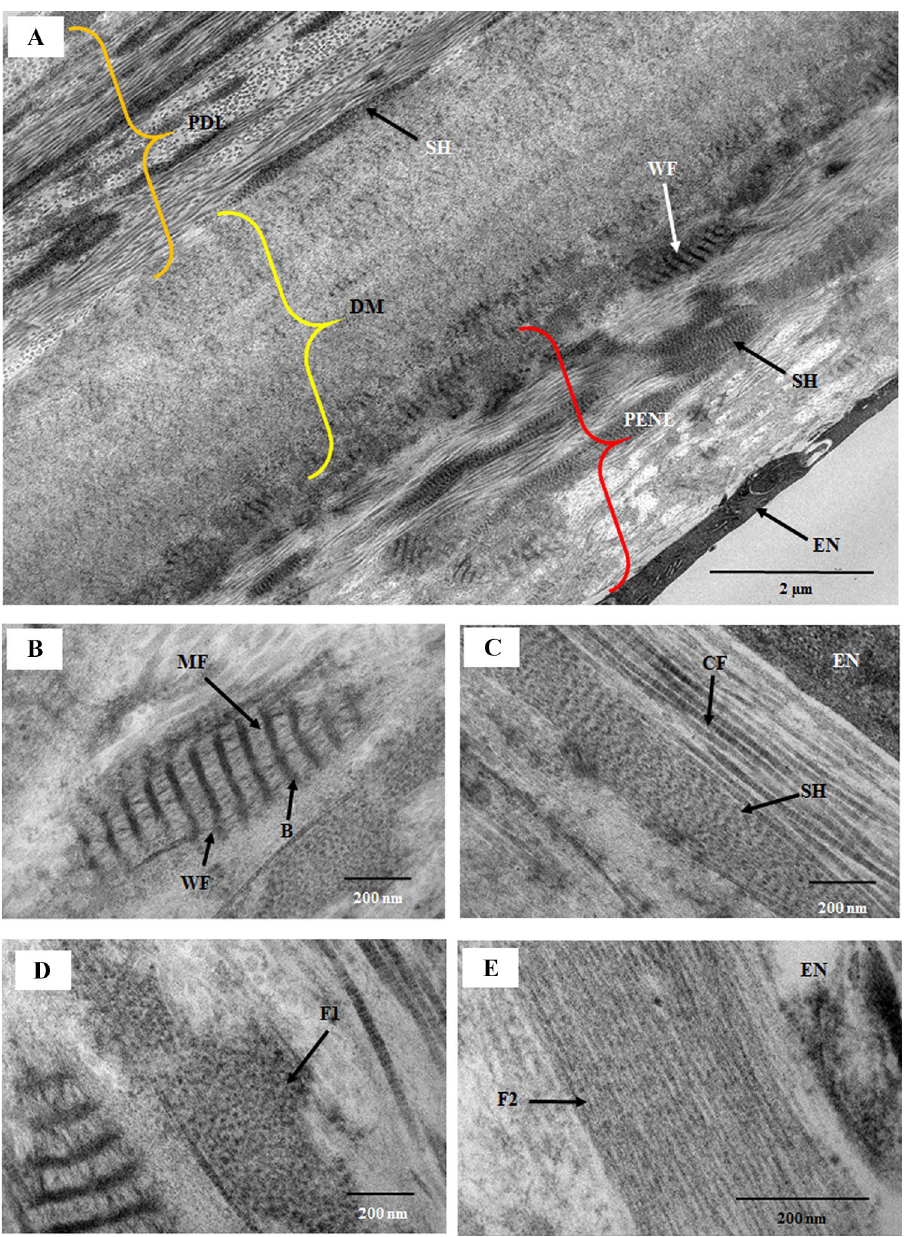
Figure 2. Electron micrograph of the posterior peripheral cornea. ( A ) Part of the posterior peripheral cornea, showing the endothelium (EN), pre-endothelial layer (PENL), Descemet’s membrane (DM), and pre-Descemet’s membrane layer (PDL). The PENL and PDL contained wide-spacing collagen, aggregates of microfibrils, and sheath material, consisting of electron-dense transverse bands (narrow-spacing fibers). DM had aggregates of the wide-spacing fibers located at its posterior surface. The major part of DM had a banding pattern. ( B ) Part of the PENL showing wide-spacing fibers containing dark bands (37.52 ± 4.99 nm) with a periodicity of 67.89 ± 5.91 nm, and the bands were connected by thin microfibrils (15.19 ± 3.00 nm). ( C ) Part of the PENL showing a sheath material consisting of electron-dense transverse bands forming a lattice. The sheath might be the outer part of the “elastic-like fibers” described by Lutjen-Drecoll et al. 18 ( D ) Part of the PENL showing a cross-section of microfibrils (F1) with a diameter of 16.13 ± 4.24 nm. ( E ) Part of the PENL showing longitudinally running thin fibrils (F2) with a thickness of 10.14 ± 2.70 nm, just above the EN. These fibrils were described as fibrils of oxytalan fibers by Carrington et al. 19 . B electron-dense bands; CF collagen fibril, DM Descemet’s membrane, EN endothelium, F1 fibrils with a thickness of 16.13 ± 4.24 nm, F2 fibrils with a thickness of 10.14 ± 2.70 nm, MF microfibrils, NB narrow bands, PDL pre-Descemet’s membrane layer, PENL pre-endothelial layer, SH sheath material consisting of electron-dense bands (narrow banded fiber), WF wide- spacing